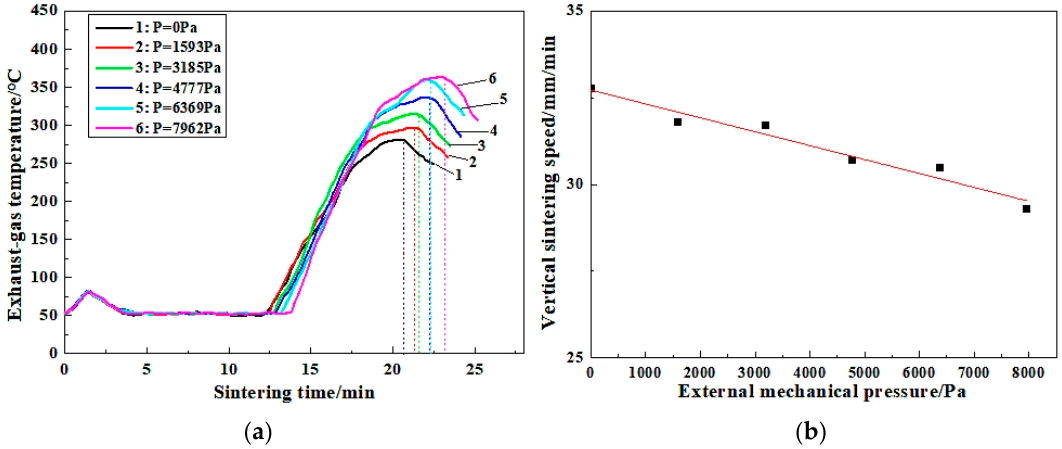
Figure 5. Variations of exhaust-gas temperature ( a ) and vertical sintering speed ( b ) with external mechanical pressure.